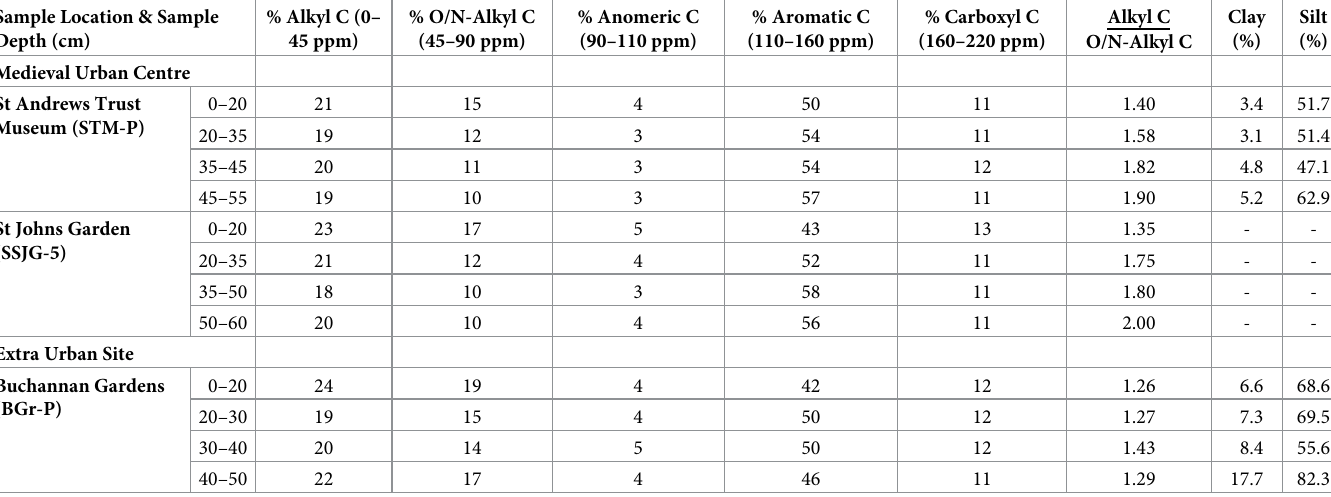
Table 1. Relative contributions of carbon species to the total signal intensity in 13 C NMR spectroscopy and particle size fractions of the soil samples. Sample Location & Sample Depth